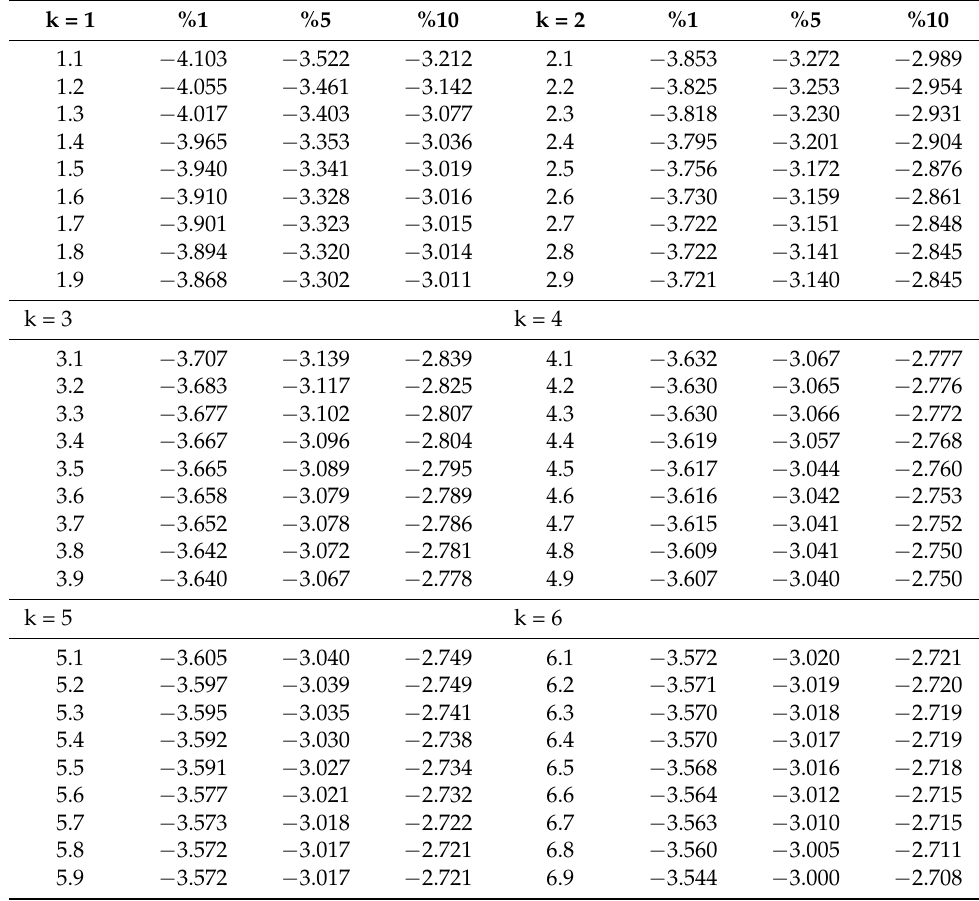
Table 2. Critical values for the two step intercept only